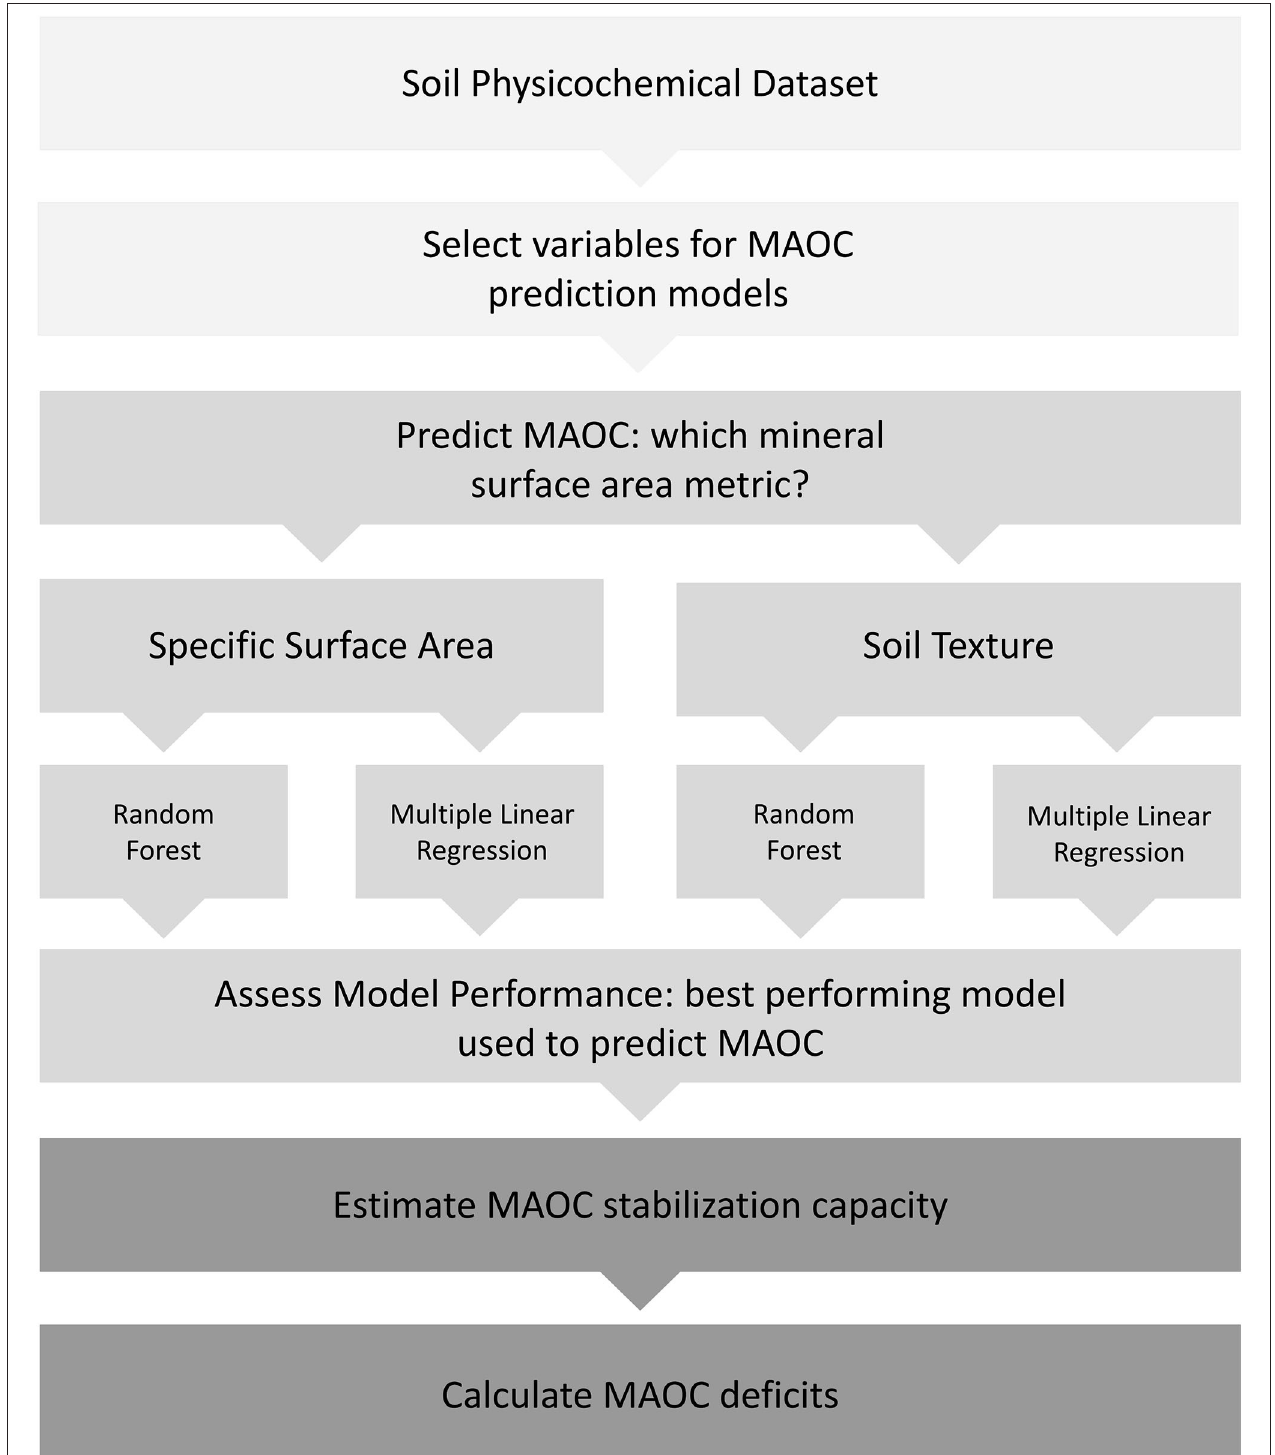
FIGURE 1 | Outline of the MAOC deficit determination process. Light gray sections denote the data acquisition and variable selection stage, middle gray denotes the model selection for MAOC estimation process, and dark gray denotes the MAOC deficit calculation process.